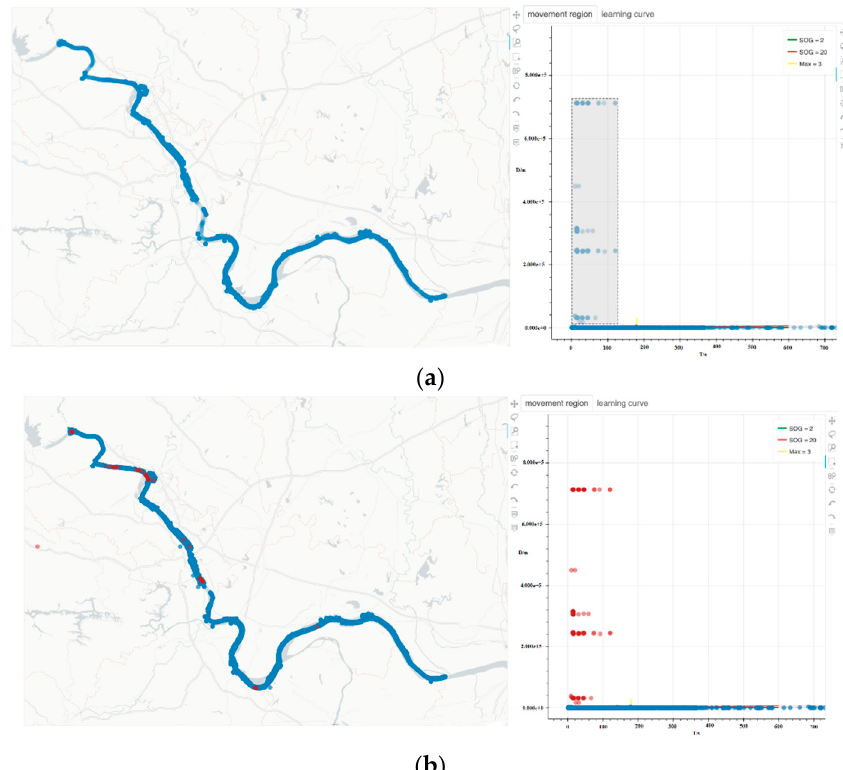
Figure 8. Box selection of the differential distance.